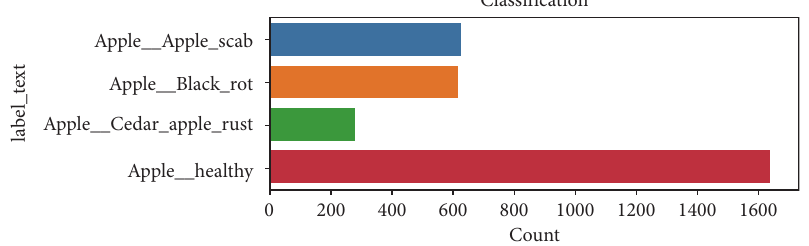
Figure 15: Subset distribution of apple data.